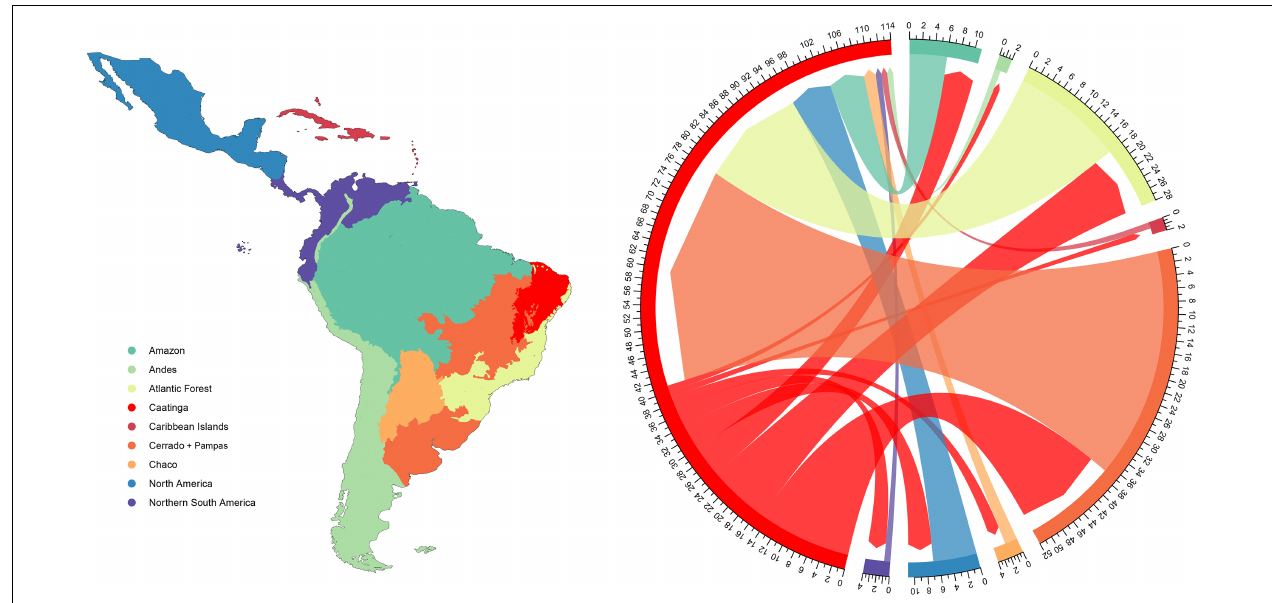
FIGURE 3 | Distribution of major areas used in our ancestral reconstructions based on reclassification of Morrone (2014) biogeographical regionalization of Neotropics and the floristic interchange among the Caatinga and other regions as estimated from DEC + j reconstructions for our sample composed of 20 lineages. Colors of the map and the chord-graph coincide and indicate the areas referred in the section “Materials and Methods.” Shapefile from Löwenberg-Neto (2014).